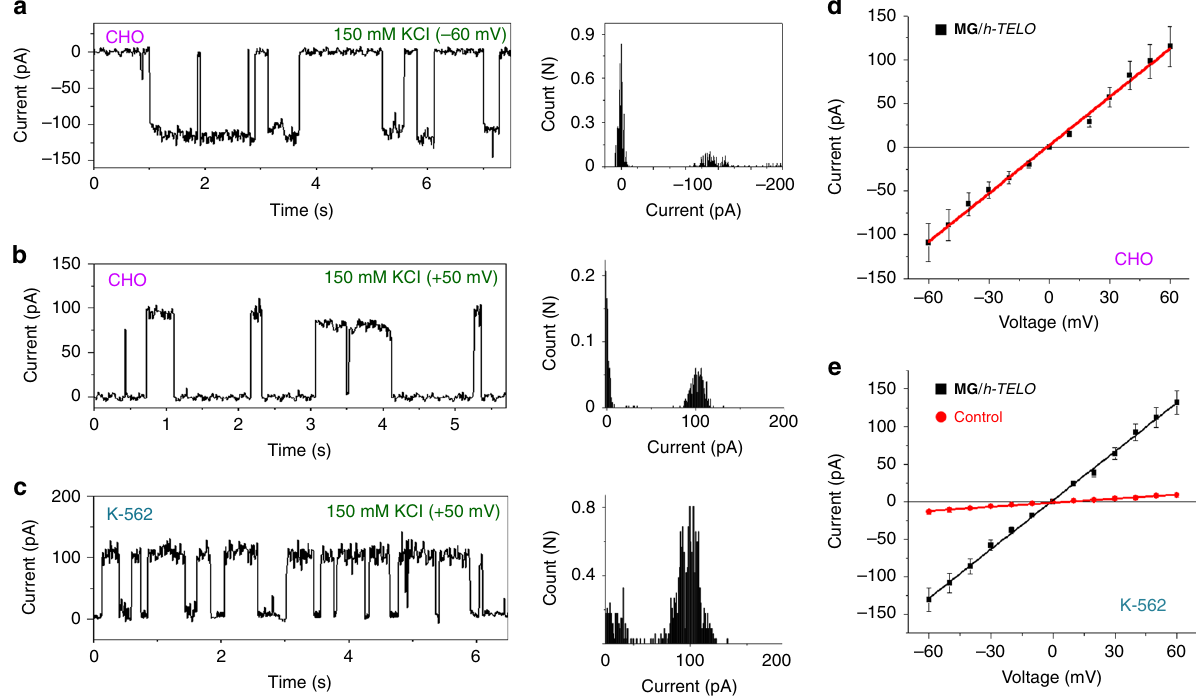
Fig. 8 Ion conductance studies across cell membrane by MG/ h-TELO . Single-channel current traces recorded at − 60mV (CHO cells) ( a ), + 50mV (CHO cells) ( b ), and + 50mV (K-562 cells) ( c ) in holding potentials in symmetrical solution of 10mM HEPES, 150mM KCl, pH 7.4 in the presence of MG / h-TELO (60 μ M). All point histograms generated from the corresponding current traces at + 50mV and − 60mV have been presented on the right. c I − V plot using a voltage ramp ( − 60mV to + 60mV) in 10mM HEPES, 150mM KCl, pH 7.4 symmetrical buffer in the presence of MG / h-TELO (60 μ M) in CHO cells ( d ) and in K-562 cells ( e ). The red line in e shows the transport in control K-562 cells. Source data are provided as a Source Data fi le. Data are means±SD ( n =